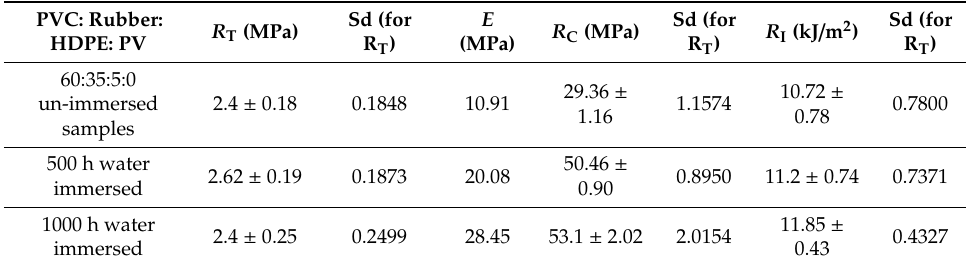
Table 1. Mechanical characteristics of the sample with no Si-PV